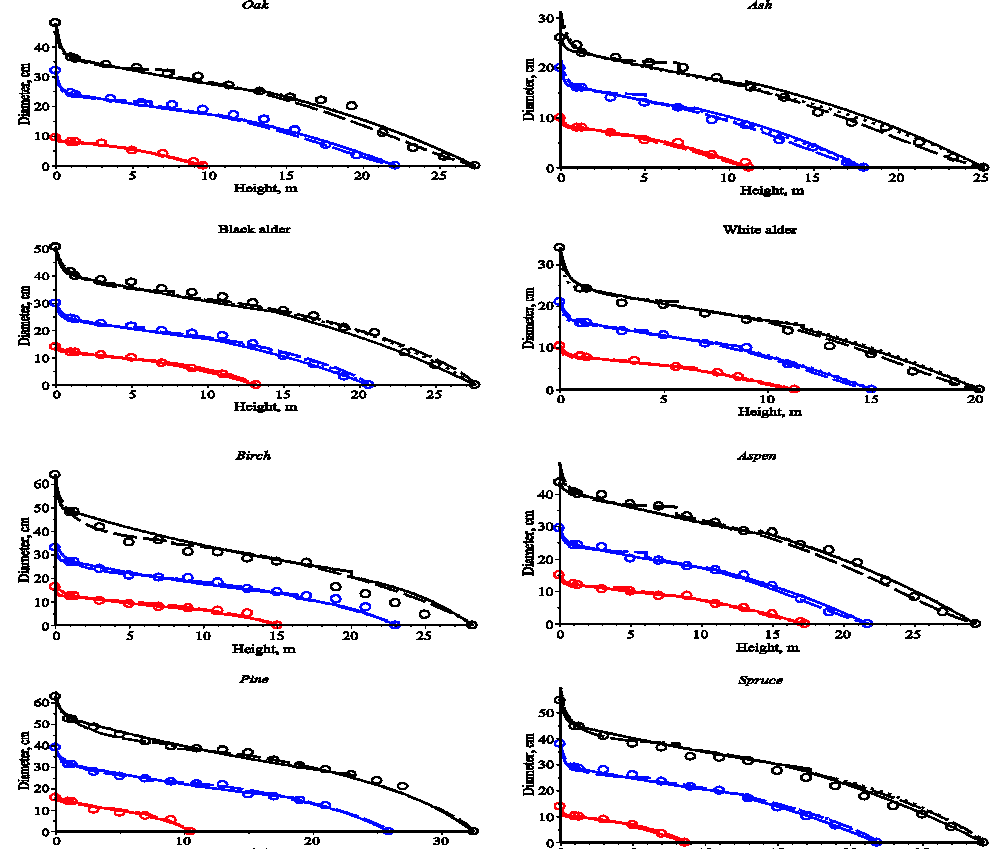
Figure 1. Comparison of fit observations for the evolution of diameter for the three stem taper models. Large tree is shown in black, medium tree in blue, and small tree in red. Model 1 is denoted by the solid line, Model 3 by the dotted line, and Model 10 by the dashed line.